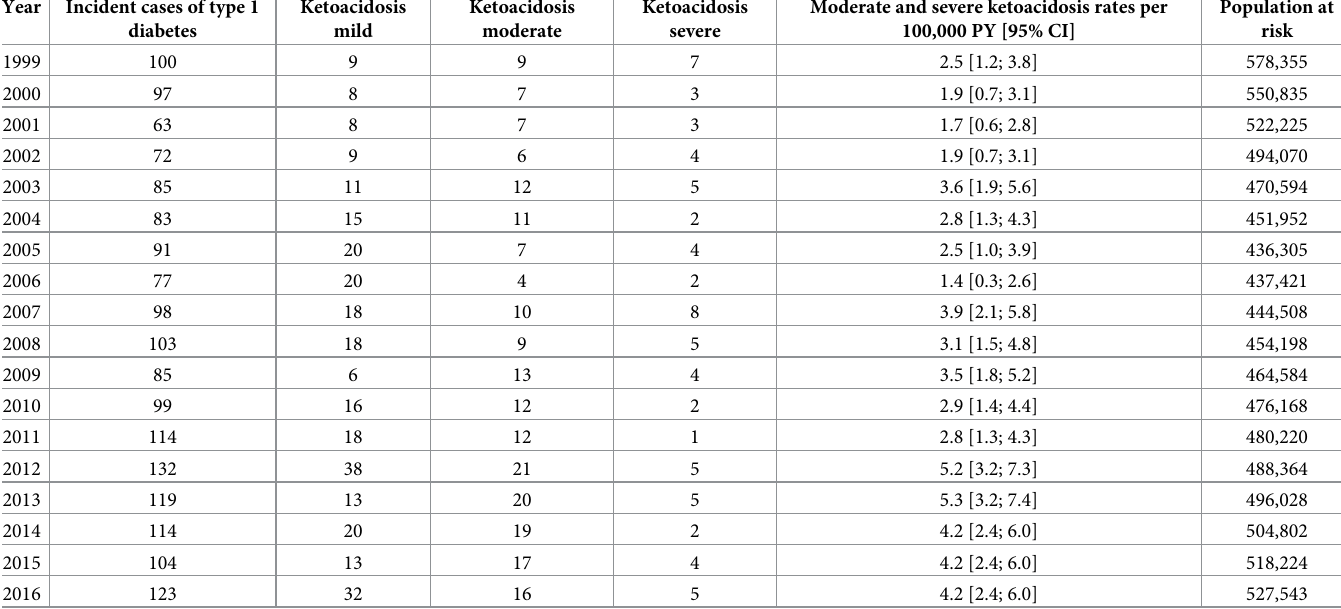
Table 1. Yearly cases of ketoacidosis at diabetes diagnosis and population at